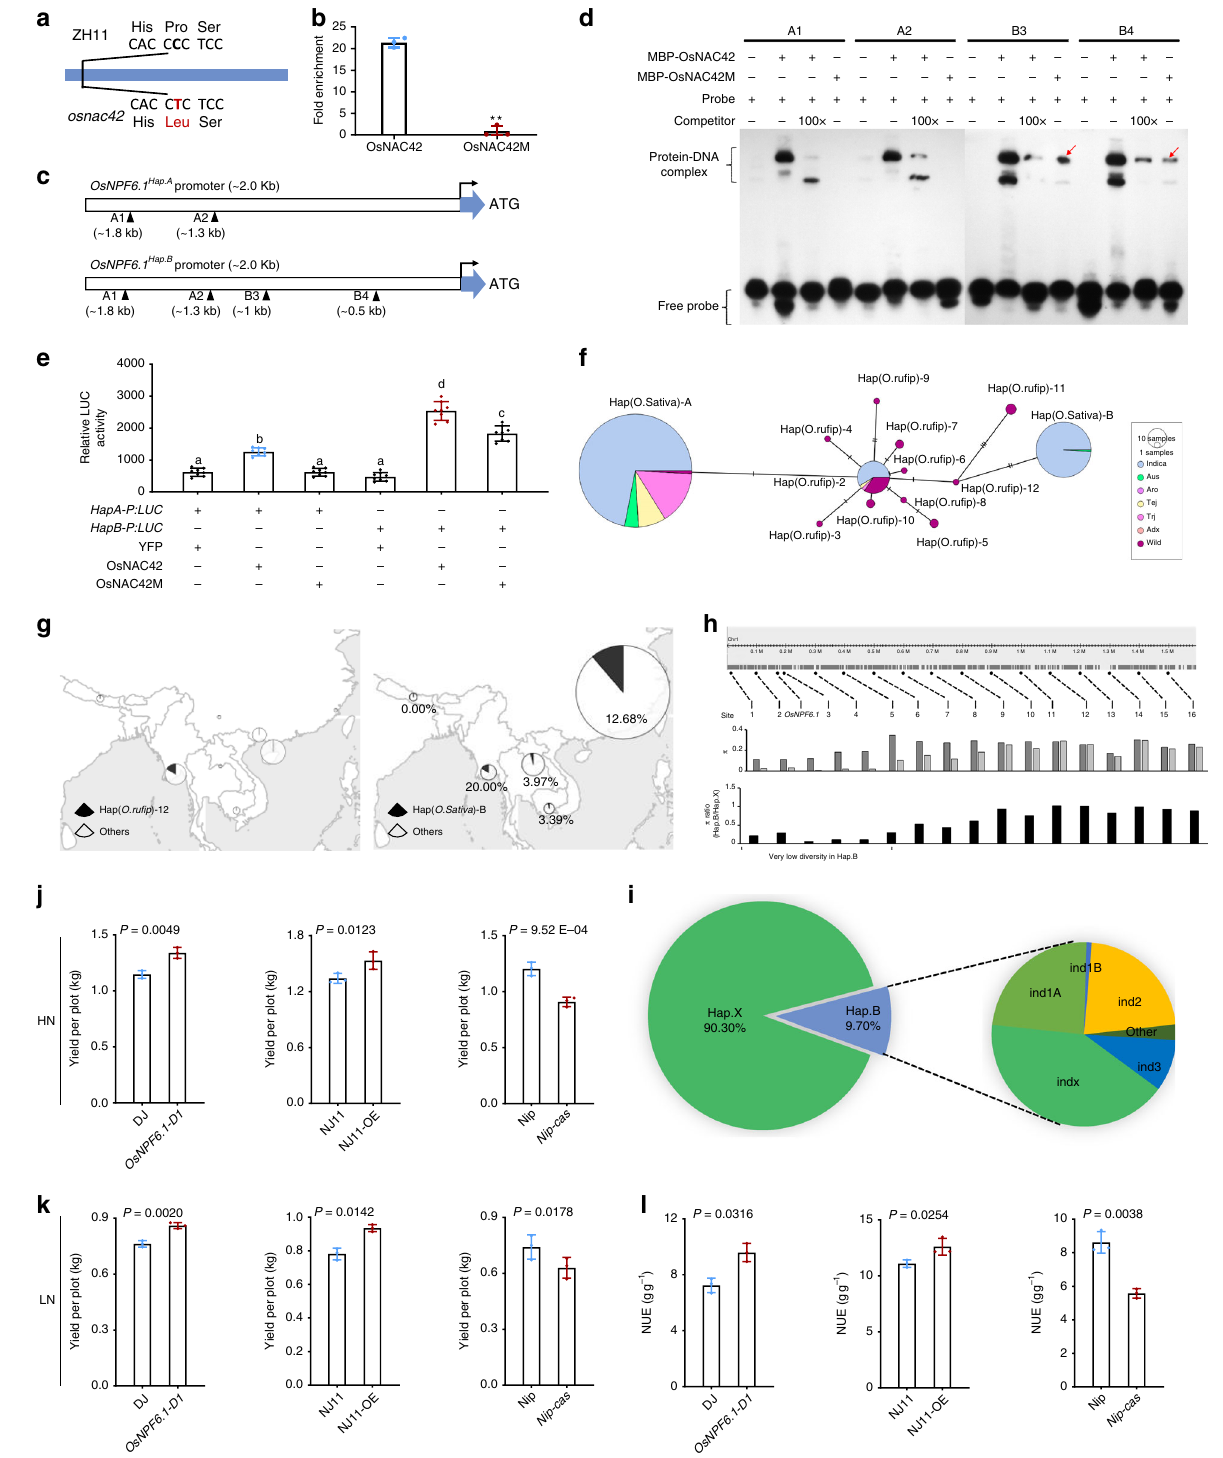
Meanwhile, OsNAC42 localizes to the nucleus, consistent with its function as a transcriptional factor (Supplementary Fig. 7b). We measured lower nitrate in fl ux rate in the osnac42 mutant under 0.25 mM NO 3 − treatment for 1 h (Supplementary Fig. 17a). We also measured the nitrogen concentration in tillering node of ZH11 and osnac42 mutant. The result showed that the nitrogen concentration of osnac42 mutant was lower than ZH11 (Supplementary Fig. 17b).